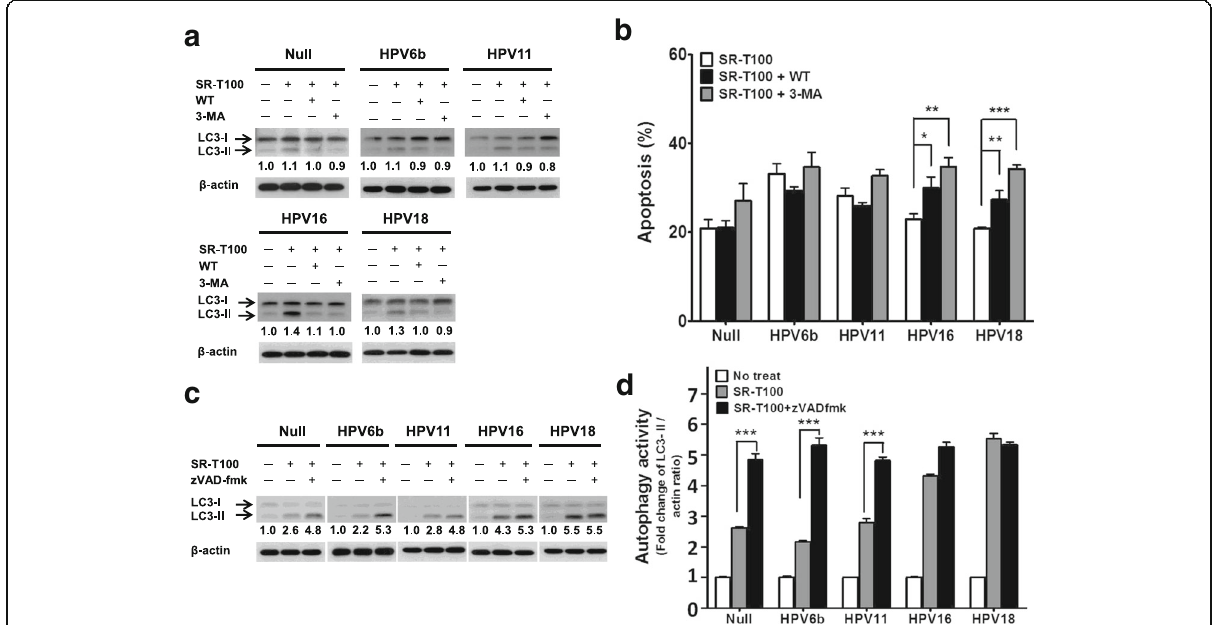
Fig. 4 Inhibition of autophagy resulted in increased apoptotic cell death in SR-T100-treated primary epithelial cells expressing HPV 16-E6/E7 and HPV18-E6/E7. a Wortmannin (WT) and 3-MA inhibited early autophagy activities in SR-T100-treated primary epithelial cells expressing HPV-E6/E7. Immunoblotting for LC3I/II using lysates from primary epithelial cells expressing different types of HPV-E6/E7 that were pretreated with the autophagy inhibitors wortmannin (WT) (200 nM) or 3-MA (2.5 mM) and then treated with or without SR-T100 (5 μ g/ml) for 12 h. The blots were stripped and reprobed with an anti- β -actin antibody to ensure equal protein loading. Similar results were observed in three independent experiments. The number indicates the fold change in the LC3-II/actin ratios in cells treated with SR-T100 versus those without SR-T100 treatment. b Histograms show the number of apoptotic SR-T100-treated (5 μ g/ml) cells (Annexin V-positive) that were incubated in the presence or absence of WT and 3-MA for 12 h. The cells were incubated with SR-T100 (5 μ g/ml) in the presence or absence of the autophagy inhibitors WT or 3-MA for 12 h. At the end of the treatments, the cells were double labeled with Annexin V-FITC and propidium iodide (PI) and analyzed by flow cytometry to evaluate cell viability. WT and 3-MA significantly increased apoptotic cell death in primary epithelial cells expressing HPV16-E6/E7 and HPV18-E6/E7. The data represent the mean ± SD from three independent experiments. * P < 0.05; ** P < 0.01. c The LC3-I and LC3-II proteins were detected by western blotting. The primary epithelial cells were infected with different types Lenti-HPV-E6/E7 virus for 24 h. After 24 h, the infected cells were incubated in culture medium in the presence or absence of the pan-caspase inhibitor Z-VAD-FMK (50 μ M) for 30 min and then treated with SR-T100 (5 μ g/ml) for 12 h. d The panel shows the percent change in the LC3-II/actin ratio compared with the untreated group in three independent